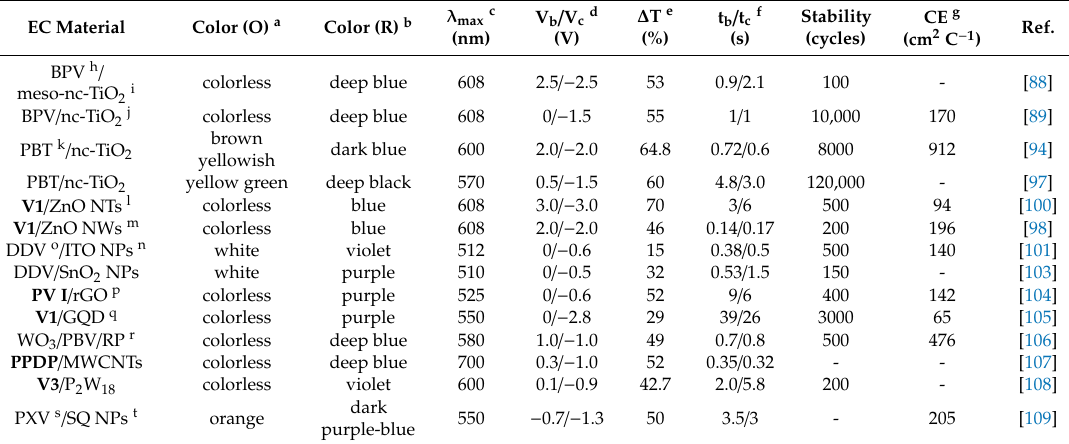
Table 3. ECD performance of various selected viologens-based composite